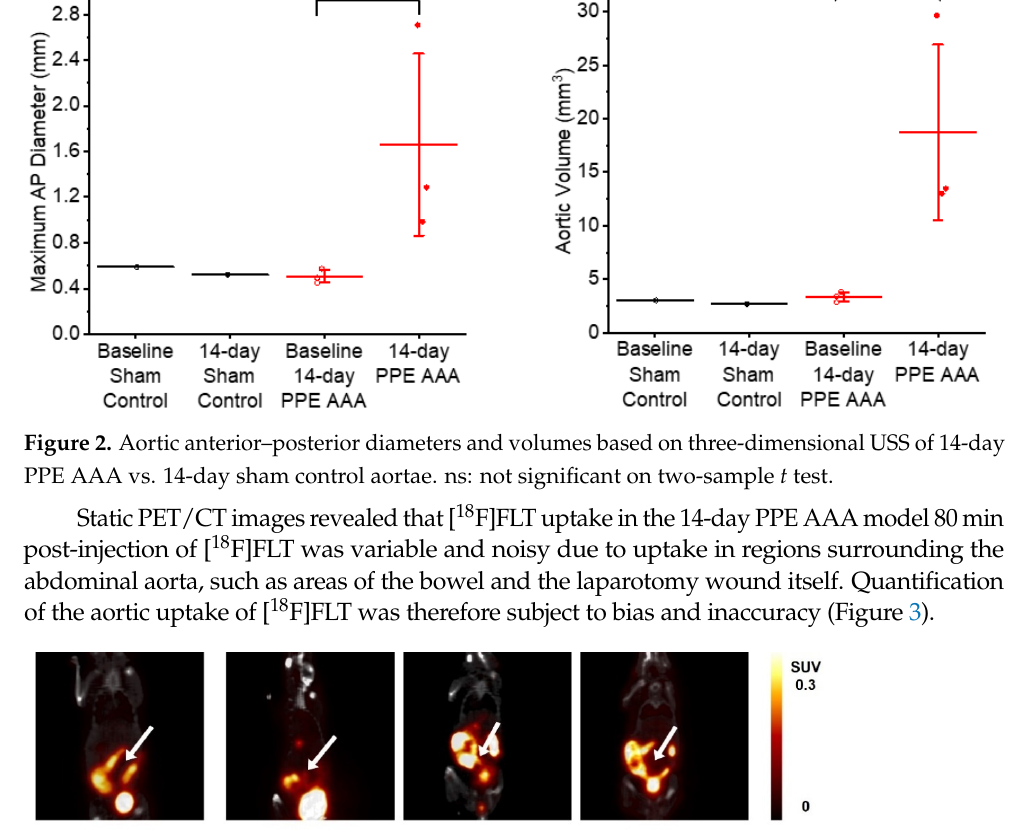
Figure 4. Decay-corrected ex vivo [ 18 F]FLT counts per mass units. ( a ) All organs. ( b ) Uptake in the spleen and abdominal aorta normalised to uptake in the heart. 4. Discussion The PPE-induced model of AAA is a well-established disease model that is less likely to rupture than the AngII-induced model, making it a popular choice of model for re- searchers [9,10]. This is the first study to investigate the uptake of [ 18 F]FLT, a cell prolifer- ation marker, in the PPE-induced murine model of AAA. We showed that [ 18 F]FLT uptake is variable in this model, despite the strong Ki67 positivity and USS-based volume and diameter indicating the presence of AAA. The following methodological points must be considered in light of these findings. The diffuse background uptake of [ 18 F]FLT was not previously observed in the AngII- induced AAA model [6], leading to the suspicion that these hotspots in the abdominal wall and intra-abdominal hollow organs were related to the laparotomy required to access the aorta to deliver the PPE (or sham control procedure). Wound healing and the devel- opment of post-surgical adhesions in the abdomen might explain this increased [ 18 F]FLT signal pattern. Competitive radiotracer kinetics might further account for the reduced